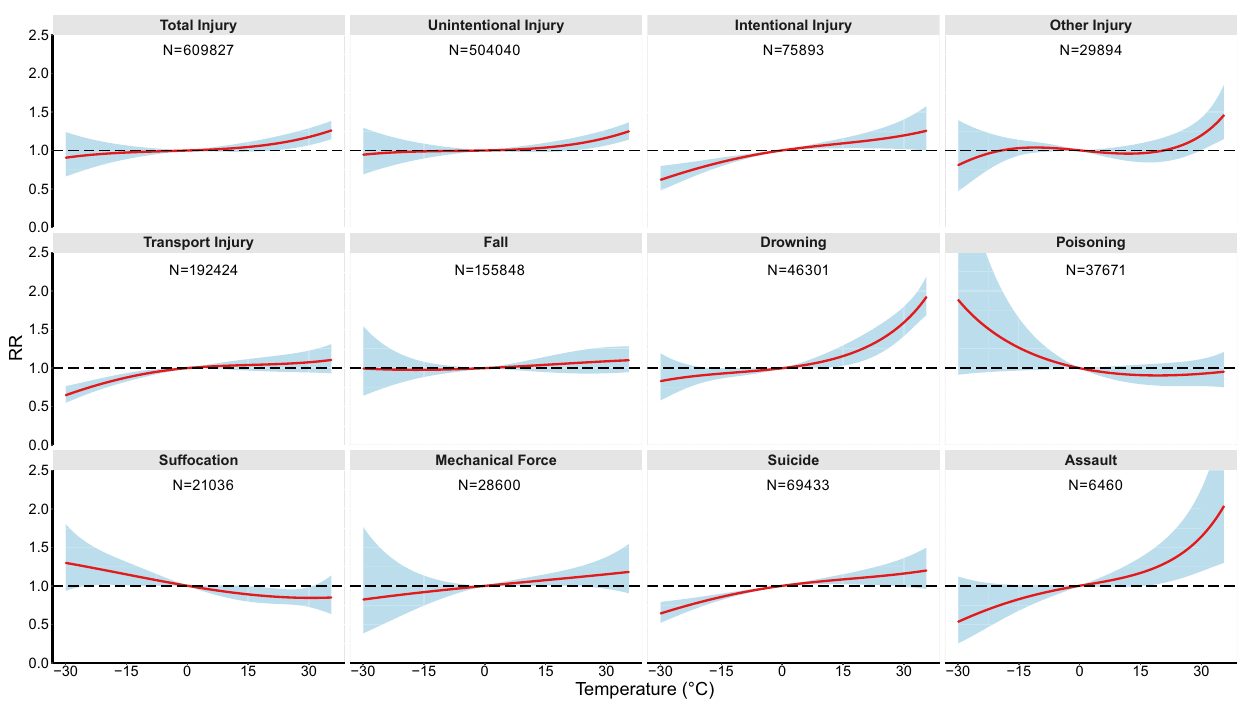
Fig. 1 | The exposure-response curves between daily mean temperature (over 0 – 1 lag days) and injury deaths by intention and mechanism. The solid lines (red) denote the relative risk of injury deaths compared to 0°C. The shaded areas denote the 95% con fi dence interval. A conditional logistic regression with cross-